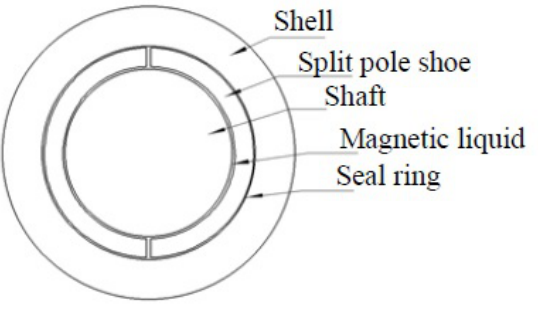
Fig. 1 Radial section diagram of seal